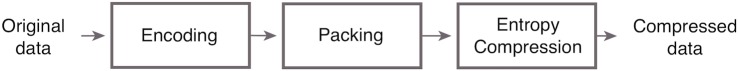
Data flow through compression algorithms.Original data are 3D coordinates of macromolecular structure. At the encoding step the coordinates are transformed to smaller values using one of the encoding algorithms described in this section. Packing converts integer values to a sequence of bytes optimizing the number of bits used to store each value. Entropy compression reduces the syntactic redundancy in encoded data representing by shorter codes symbols that occur more frequently.